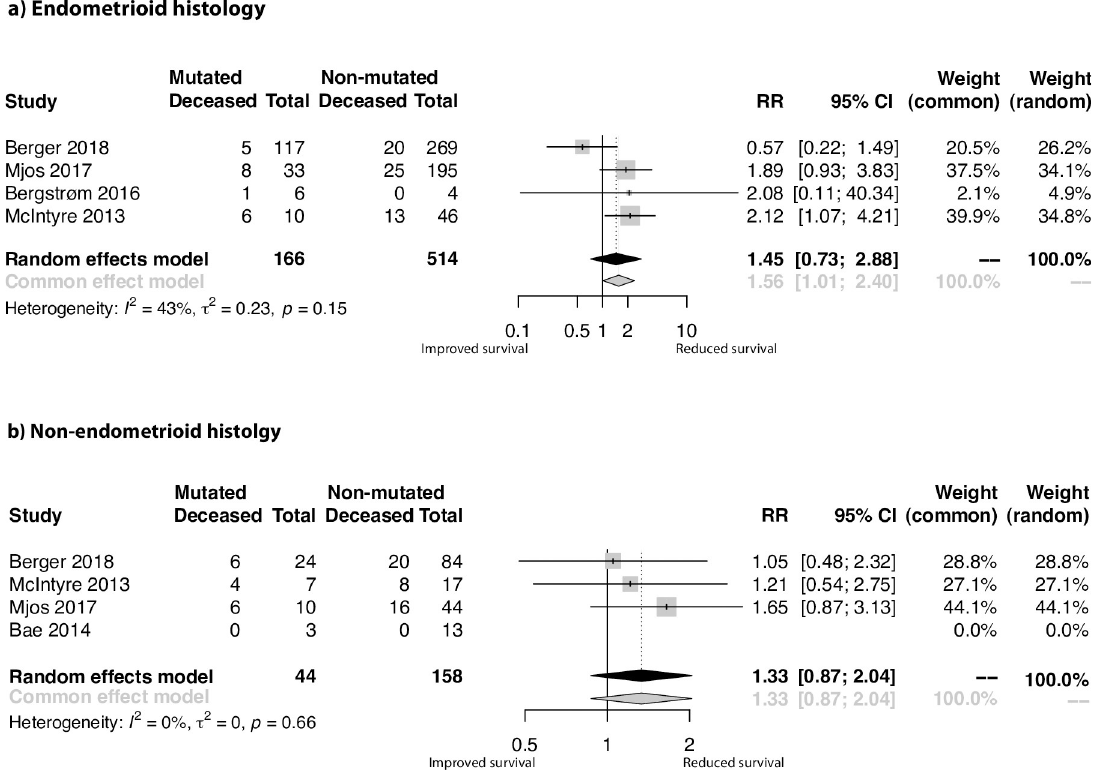
Fig 3. Meta-analysis results of the effect of PIK3CA mutations on EC patient survival related to histologic type. Forest plots of the relative risks (RR) of combined overall and disease-specific survival in a) endometrioid and b) non-endometrioid subgroups.